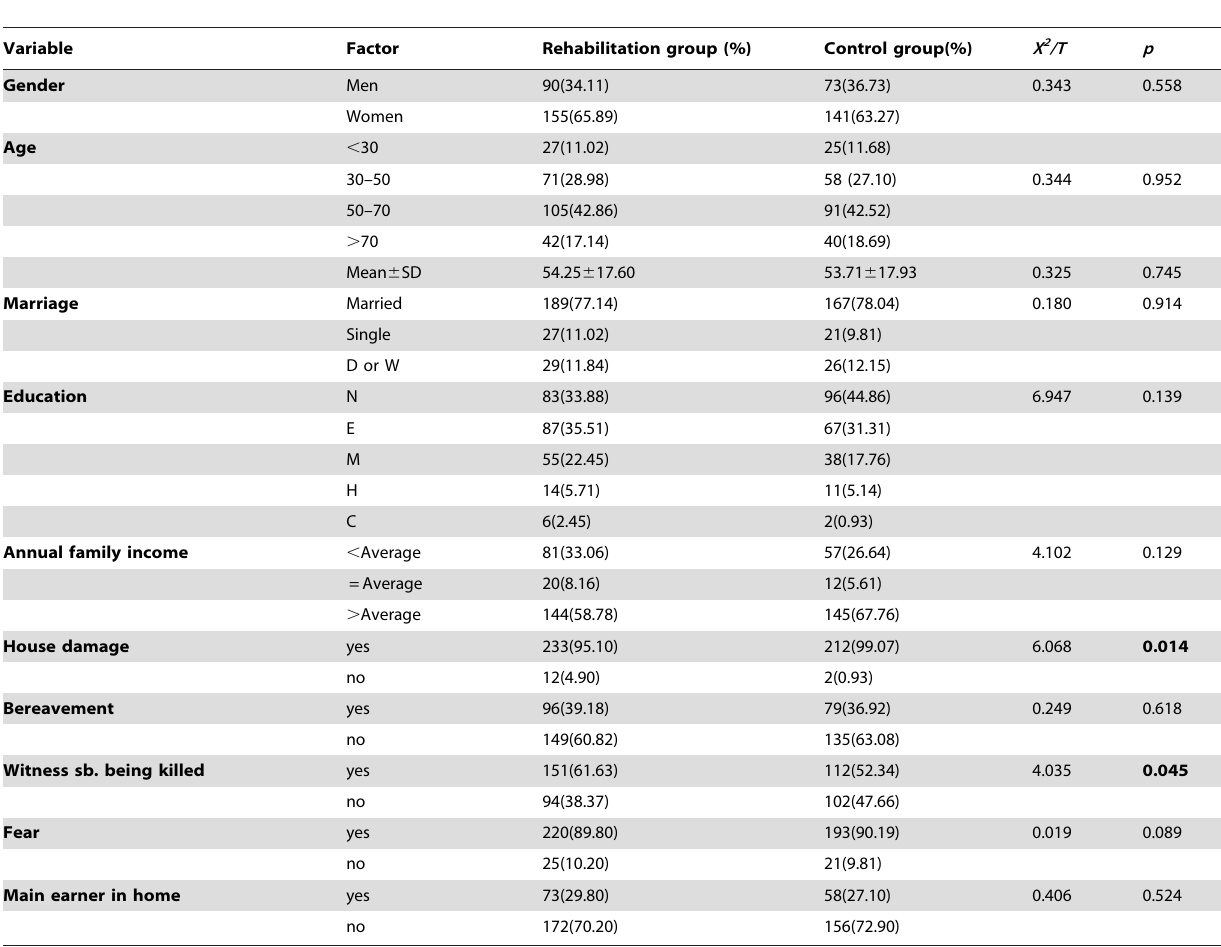
Table 1. Sample description and comparison of study groups.